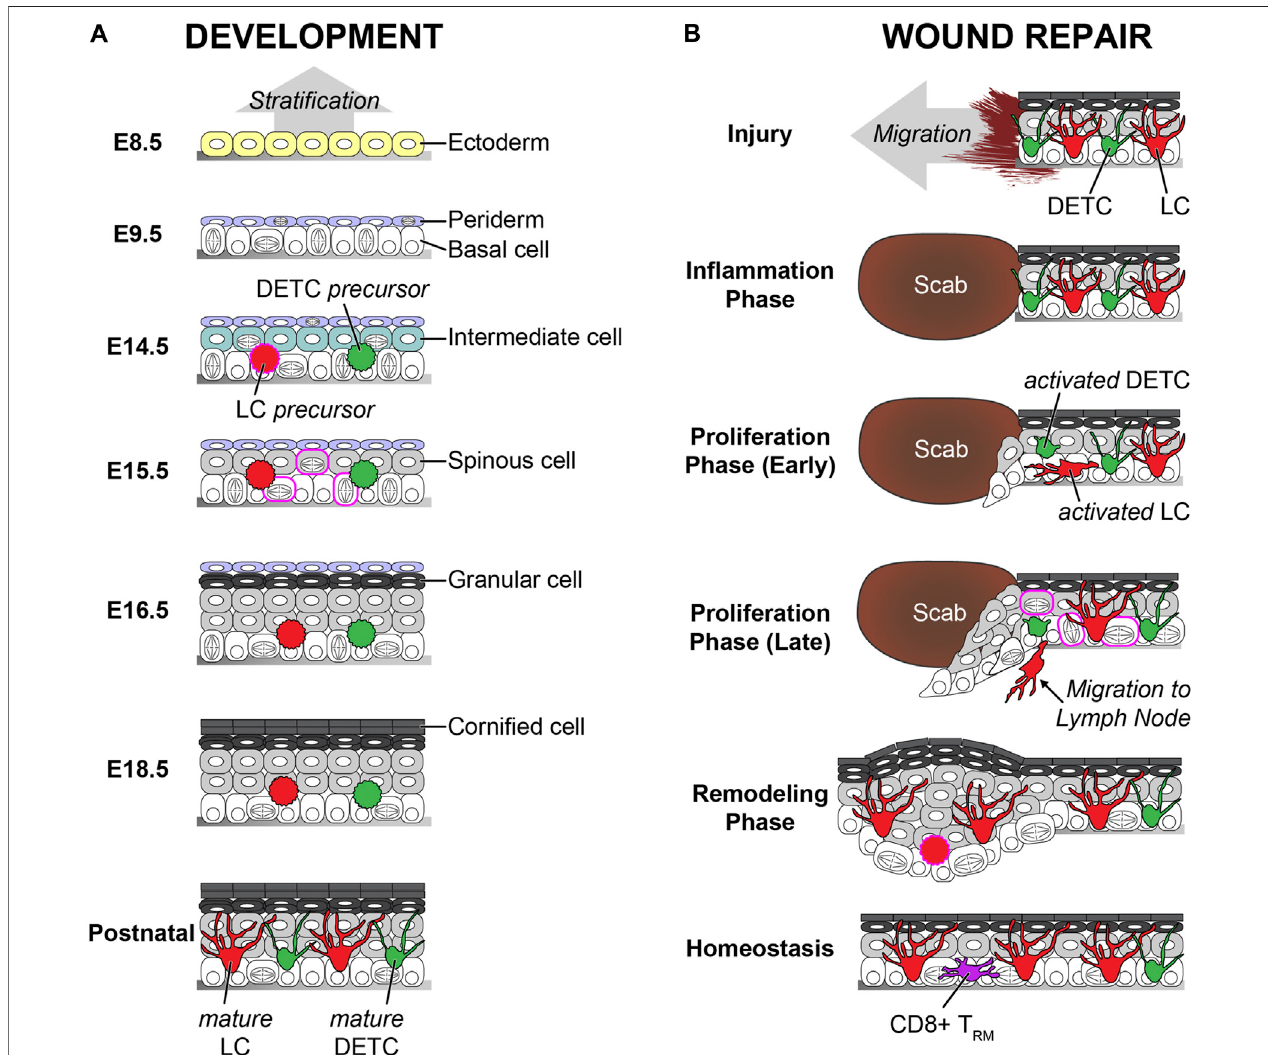
FIGURE 2 | Comparison of the development and the wound repair of the epidermis. (A) The vertical strati fi cation builds the epidermis during the development. Ectoderm-derivedsinglelayercellsonthebasementmembranedifferentiatetothebasallayercells.Basallayercellsmaketheperidermonthetopandtheintermediated layerbetweenthebasallayerandtheperiderm.Theintermediatecellschangetospinouscells.Thespinouscellsdifferentiateintogranularcells.Theperidermshedsoffat the later stage of the embryogenesis, and the granular cells differentiate to the corni fi ed cells before birth. Both precursors from LCs and DETCs are seeded in the epidermisattheearlyembryogenesis.Theseimmaturecellsincreasethenumberbyproliferationburstandchangetodendriticmorphologybymaturationafterbirth.The embryonic days (E) are based on mouse embryogenesis. (B) The lateral migration rebuilds the damaged epidermis during the wound repair. The in fl ammation phase is initiated right after the injury. Next, the re-epithelialization starts during the proliferation phase. Both undifferentiated basal and differentiated spinous cells migrate together. Proliferation is dramatically increased. Migrating cells and cells in the spinous layer show cell division during re-epithelialization, which are not observed during homeostasis. The epidermis becomes thick after the re-epithelialization, and the thickness gradually decreases during the remodeling phase. Both DETCs and LCs are activated after the in fl ammation phase. The activated DETCs become round, and the activated LCs lose contact with the tight junctions. The activated LCs leave the epidermistomigrate tothelymphnode.LCdensity islowright afterthere-epithelialization,but LCsrecoverthenormaldensityduring theremodelingphase. TheDETCs do not exist in the neo-epidermis, and CD8 + TRMs replace the territory of the DETCs. Similar features between the development and the wound repair are labeled in magenta. During the wound repair, the proliferation rate is dramatically increased, and even asymmetric and spinous divisions are observed like the development. In addition, there is a possibility that LC precursors repopulate on the neo-epidermis like the development.